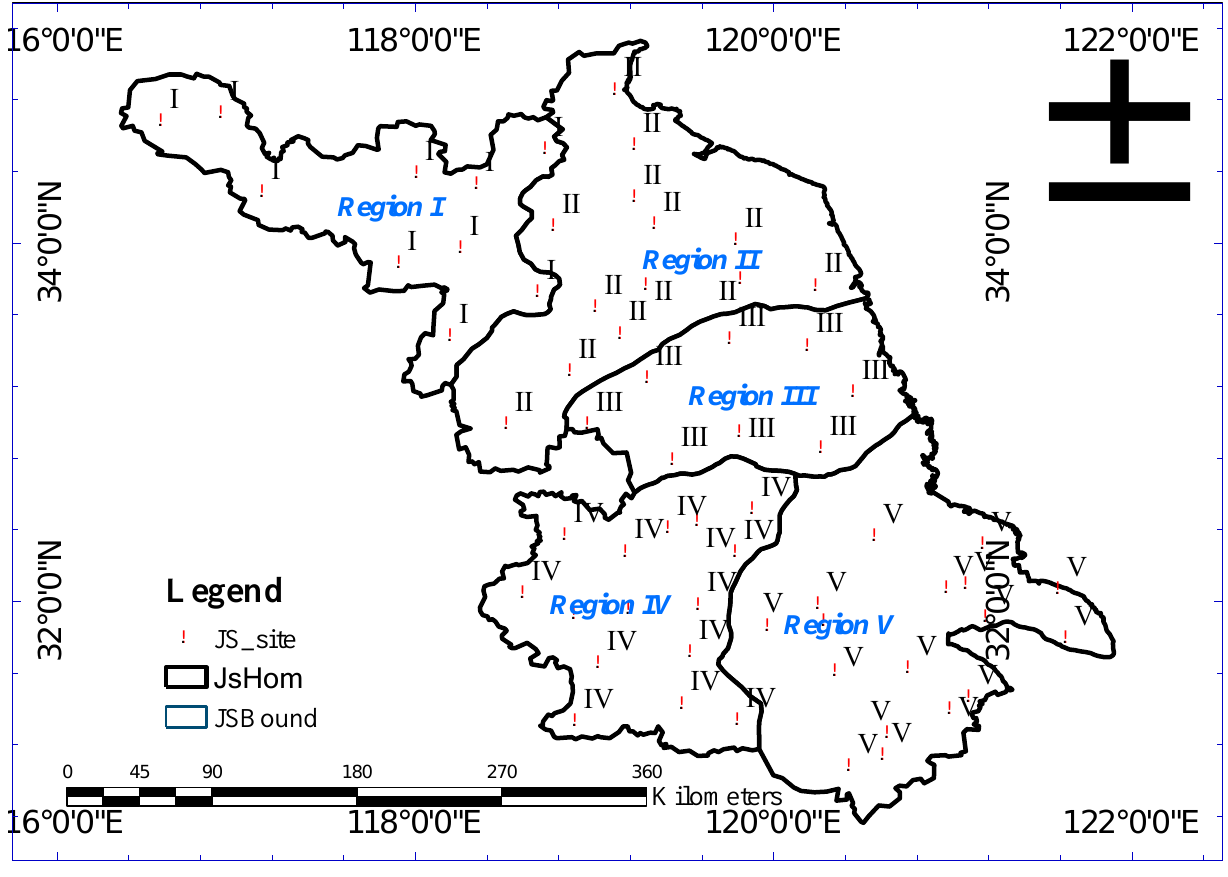
Figure 2. Spatial map of five homogeneous regions. The results of the goodness-of-fit simulation experiments for the five regions are shown in Table 2. It can be seen from Table 2 that GLO and GEV are, respectively, the optimum distributions based on the two indices of |Z| and the RMSE for regions I and III, IV, and V. For region II, GNO is the best distribution from the |Z| value, and GEV is the best based on the RMSE . However, the difference between the |Z| and RMSE estimations is small. Therefore, GNO and GEV can be considered as the best-fitting distributions based on the two tests. However, abrupt changes in frequency estimations at the borders of adjacent homogeneous regions should be avoided. The frequency estimation has a good correlation with the tail thickness of distribution and decreases in the order of GLO, GEV, GNO, GPA, and PE3. The regions adjacent to region II have an appropriate fit with GLO. Therefore, GEV is the best distribution based on the two tests and the change in adjacent regions. Similarly, the optimum distributions of the five regions for the AES data are GNO, GPA, GPA, GPA, and